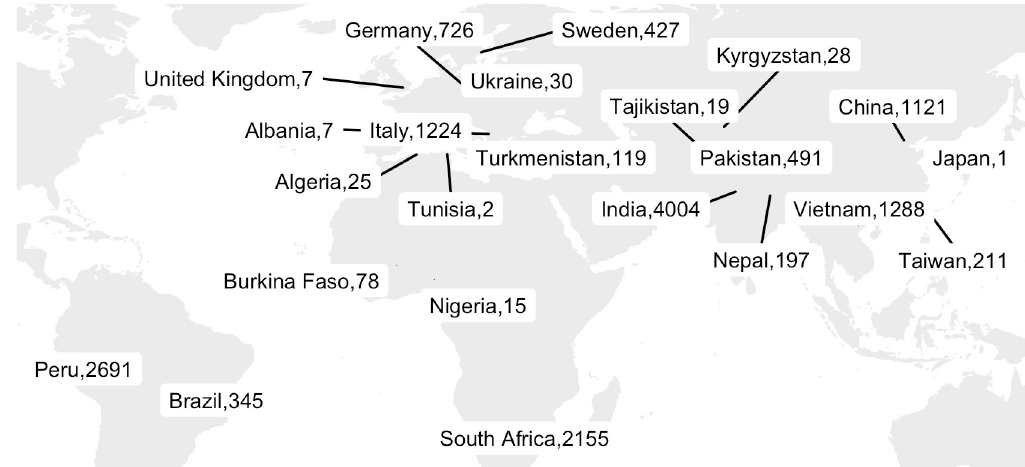
Fig 2. Geographical distribution of 15,211 CRyPTIC Mycobacterium tuberculosis clinical isolates (“full” dataset). The total number of isolates contributed by each country is depicted. Where the origin of an isolate was not known, the collection site identity was assigned (this occurred for 269 isolates in Germany, 17 isolates in India, 6 isolates in Peru, 885 isolates in Italy, 510 isolates in South Africa, 357 isolates in Sweden, 208 isolates in Taiwan, 1 isolate in Brazil, and 4 isolates in the UK). The base layer map was sourced from Natural Earth, which is in the public domain (see http://www.naturalearthdata.com/about/terms- of-use/), and created using the R packages “ggmap” and “maps” (see github.com/kerrimalone/Brankin_Malone_2022/).